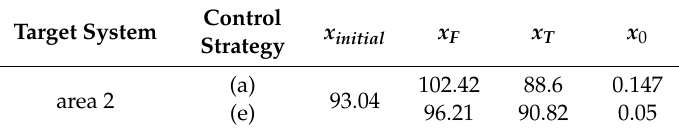
Table 4. Overcorrection results of (a) and (e) in area 2.